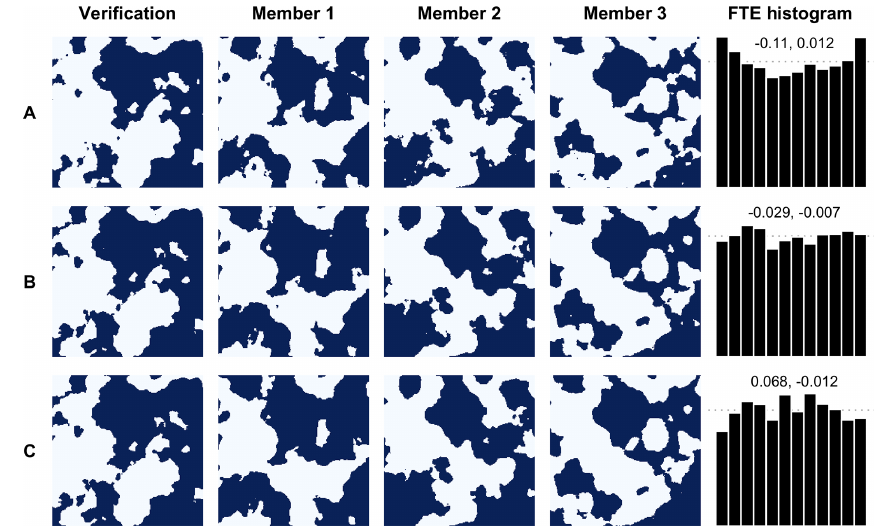
Figure 3. As Fig. 2 but ensemble fields have correlation length a M = 1 . 8 , 2 , 2 . 2 in rows A, B, and C,